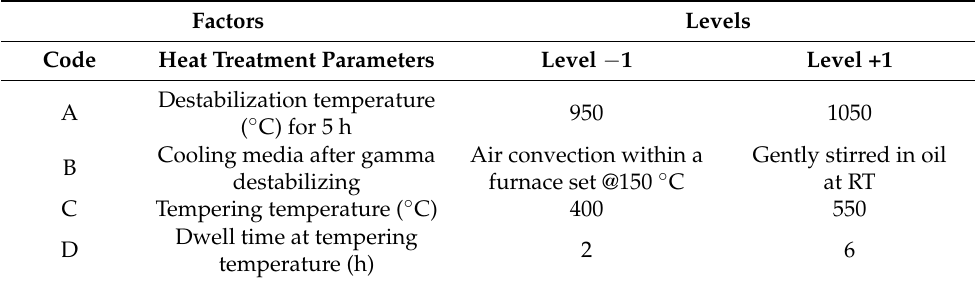
Table 2. Factors and